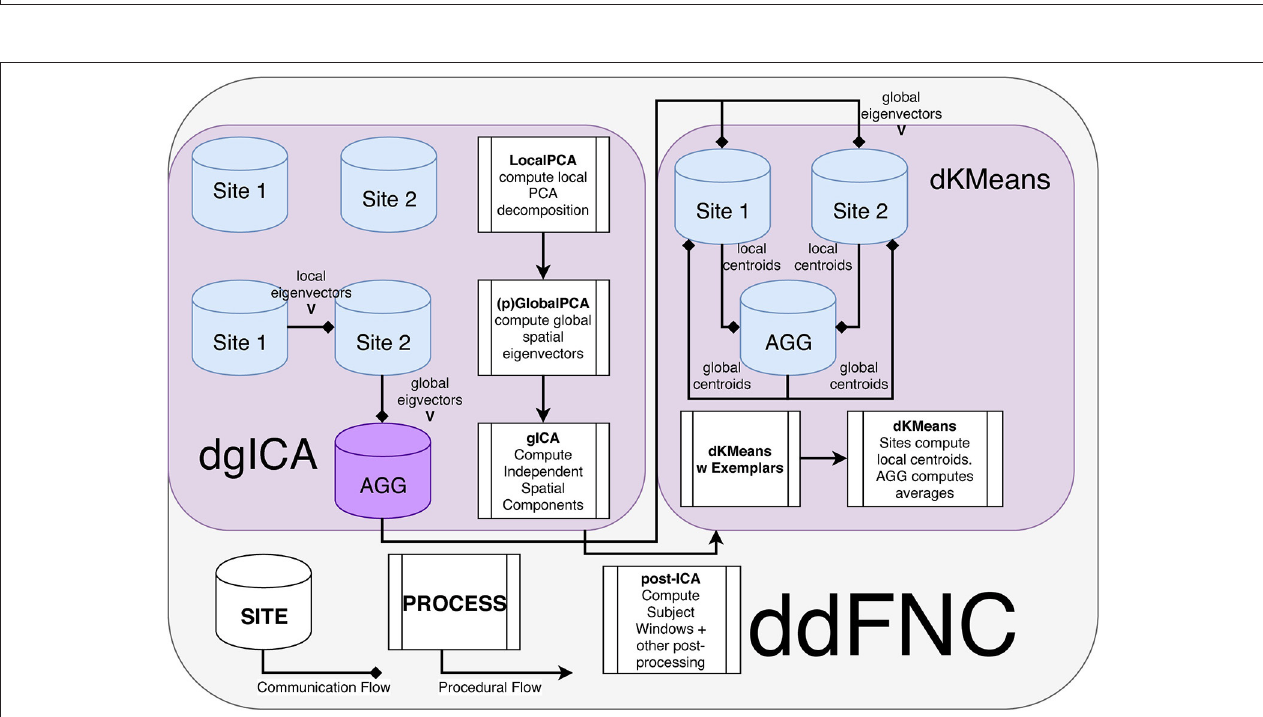
FIGURE 7 | Flowchart of the ddFNC procedure e.g., with 2 sites. To perform dgICA, sites first locally compute subject-specific LocalPCA to reduce the temporal dimension, and then use the GlobalPCA procedure from Baker et al. (2015) to compute global spatial eigenvectors, which are then sent to the aggregator. The aggregator then performs ICA on the global spatial eigenvectors, using InfoMax ICA (Bell and Sejnowski, 1995) for example, and passes the resulting spatial components back to local sites. The dK-Means procedure then iteratively computes global centroids using the procedure outlined in Dhillon and Modha (2000), first computing centroids from subject exemplar dFNC windows, and then using these centroids to initialize clustering over all subject windows.